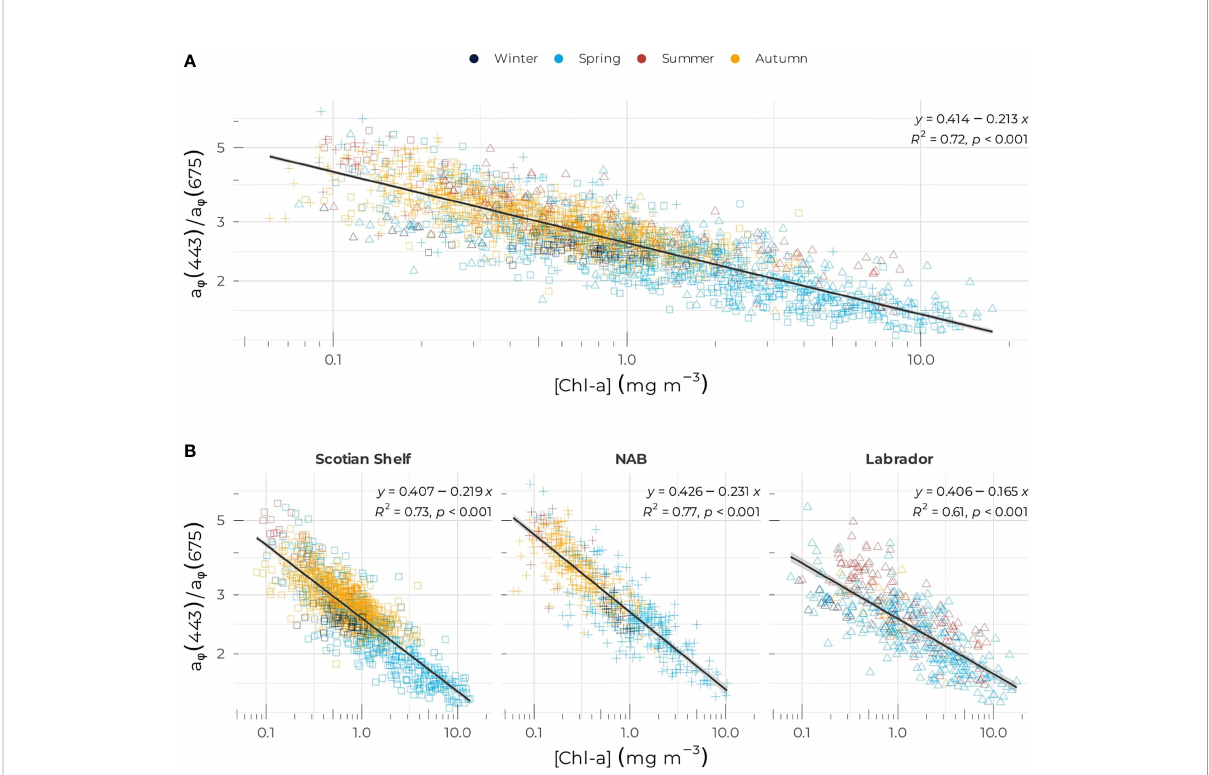
FIGURE 6 Ratio of a f (443) to a f (675) as a function of [Chl-a] for (A) the entire dataset and (B) the Scotian Shelf (left panel), the Northwest Atlantic Basin (middle panel), and the Labrador Sea (right panel). Symbols are color-coded according to season as in Figure